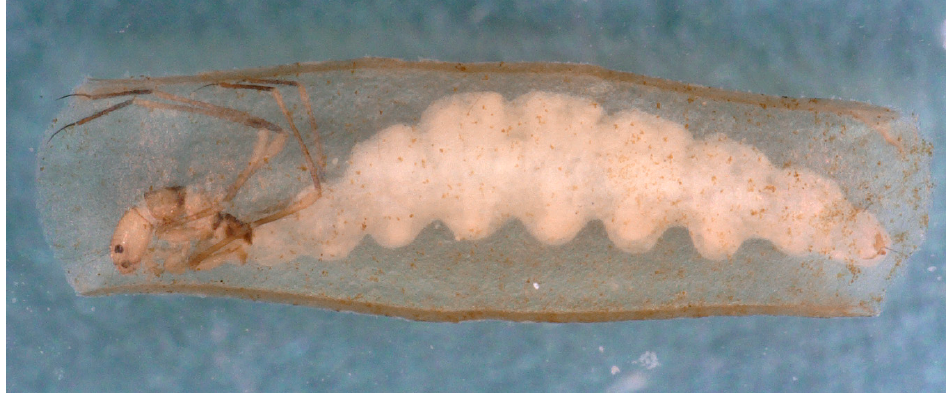
Figure 7. Larvae of Tricholeiochiton fagesii (Guinard, 1879) (Hydroptilidae) in its case. © W. Graf.